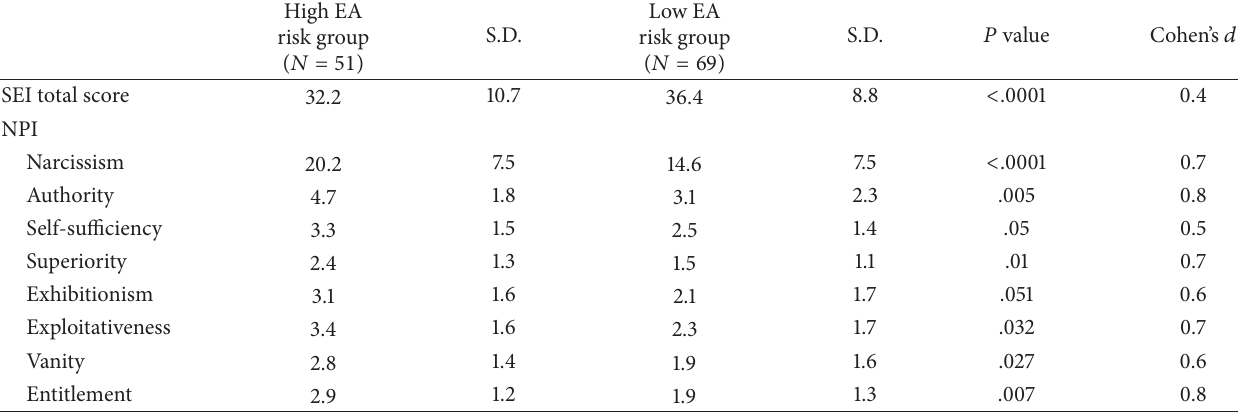
Table 2: Coopersmith Self-Esteem Inventory (SEI) and Narcissistic Personality Inventory (NPI) scores in high EA risk and low EA risk groups.